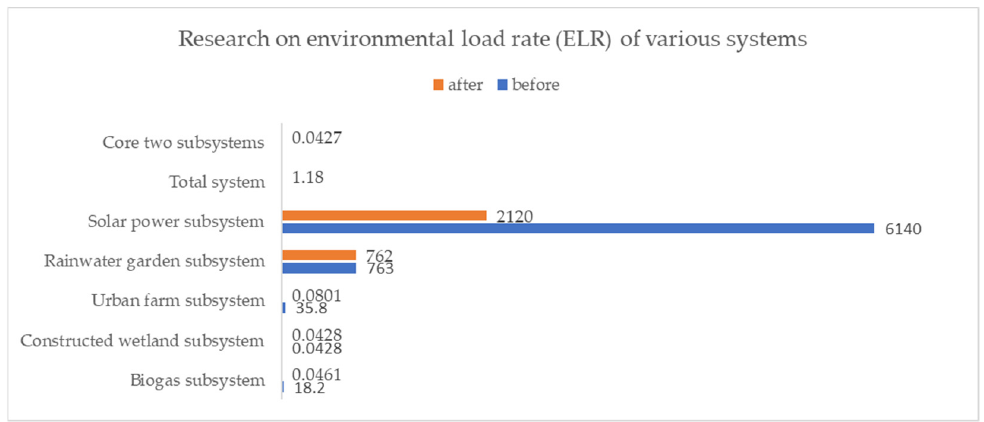
Figure 10. Research on environmental load rate (ELR) of various systems.